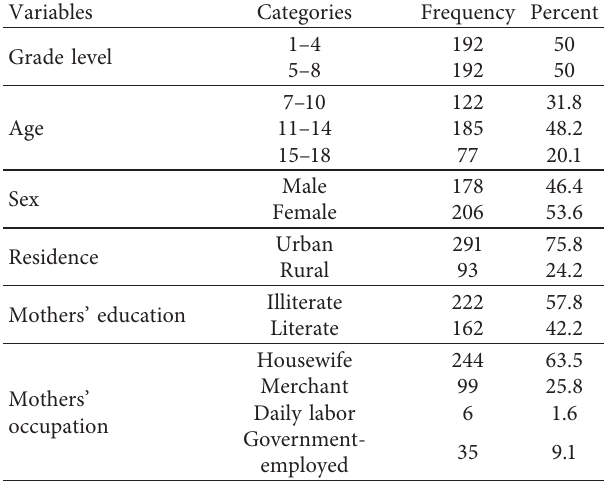
Table 1: Sociodemographic characteristics of Maksegnit grade school children, 2018/2019.